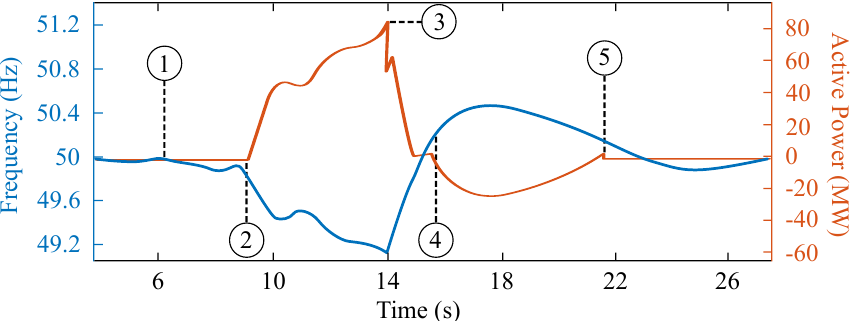
Figure 10. Frequency support of the Hornsdale Power Reserve (HPR) to 25 August 2018 separation event (plot drawn with data from [68]).